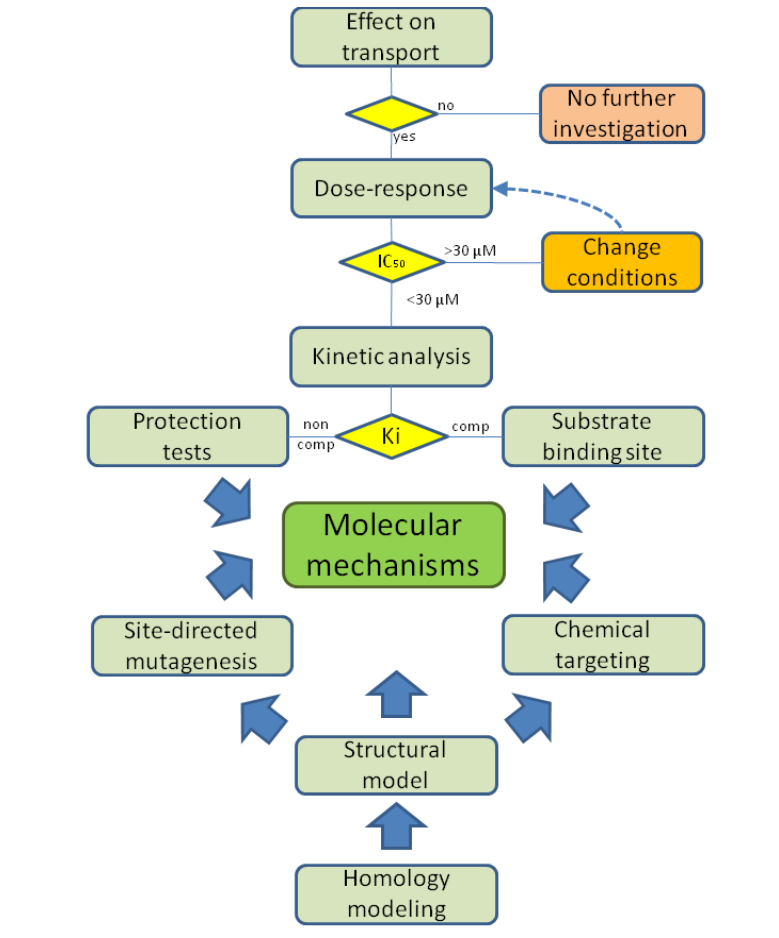
Figure 3. Work plan for xenobiotic-transporter interaction studies in